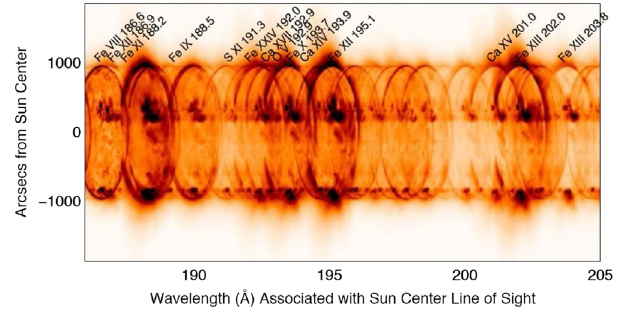
Fig. 6. A simulated image of the slitless spectrograph channel, based on SDO /AIA data, shows the full-disk solar images produced by this instrument. The contracted plate scale in the dispersion direction is due to the off-normal angle of incidence employed for higher spectral resolution.